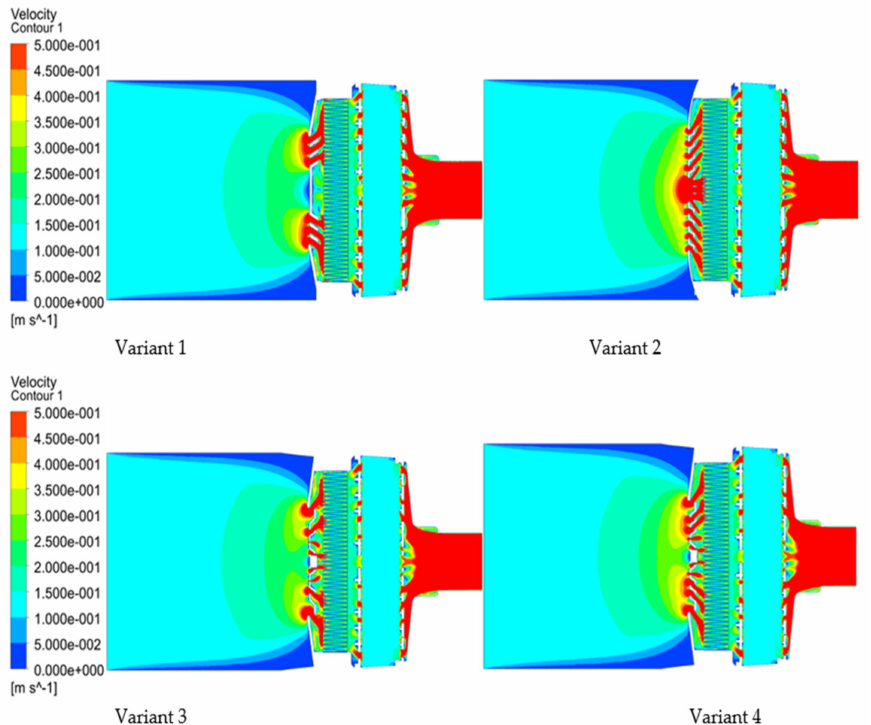
Figure 11. Velocity distribution in longitudinal sections for four variants of lid at flow rate 70 L/s. Pleat height is 13.5 mm and spacing is 2 mm.